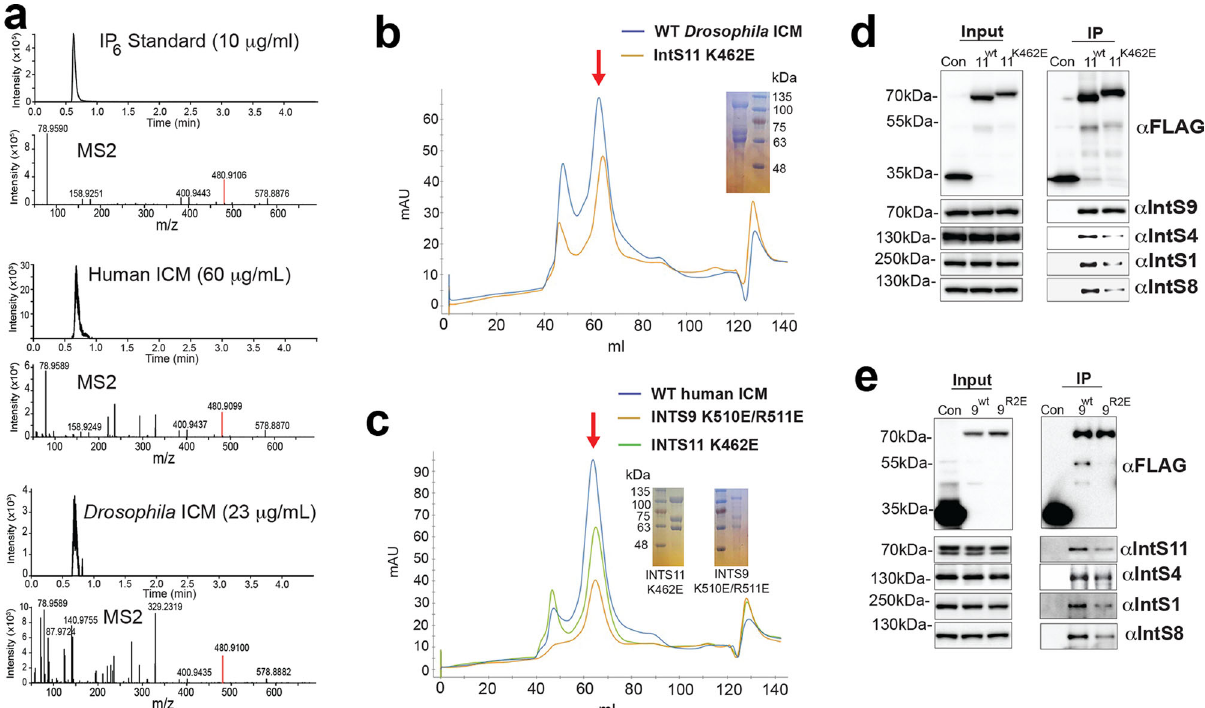
Fig. 6 | Mutations in the IP 6 -binding site do not completely abolish Integrator assembly. a Chromatograms (upper panel) and fragmentation spectra (lower panel) for the IP 6 [M-2H] ion for IP 6 standard, wild-type human ICM, and wild-type Drosophila ICM. The IP 6 signal for Drosophila ICM is weaker due to the lower proteinconcentration. b Gel fi ltrationpro fi lesofwild-type(WT)andK462Emutant of Drosophila ICM, and SDS gel of the mutant. The position of the complex is indicated with the red arrow. The experiment for the mutant was done one time. mAUmilli Absorption Unit. c Gel fi ltration pro fi les of wild-type, K462E, and